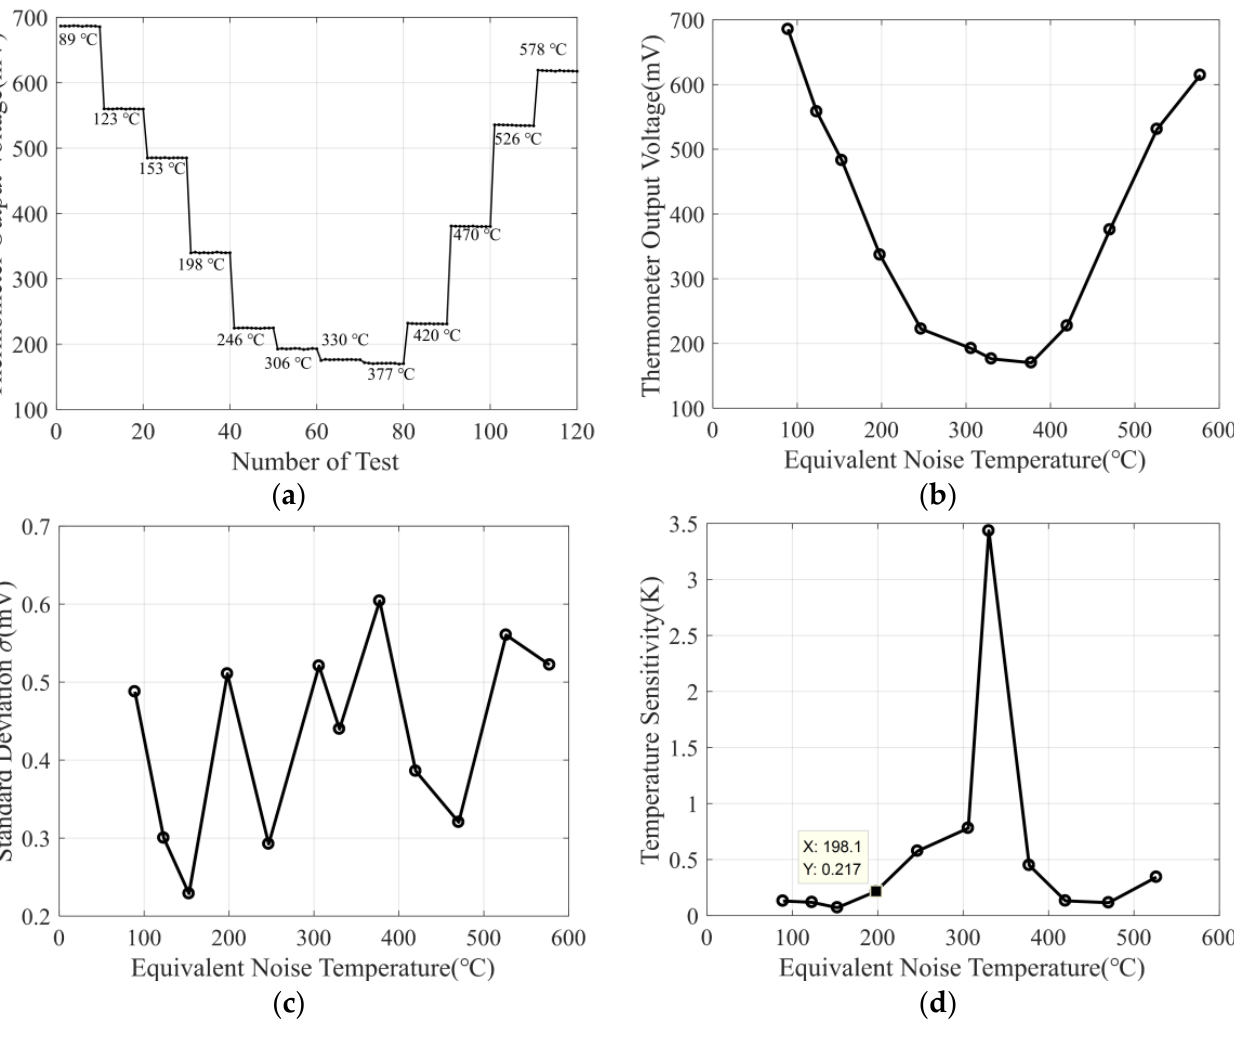
Figure 20. The measurement result of the thermometer: ( a ) thermometer output voltage versus equivalent noise temperature; ( b ) thermometer average output voltage versus equivalent noise temperature; ( c ) standard deviation of thermometer versus equivalent noise temperature; ( d ) thermometer temperature sensitivity versus equivalent noise temperature.